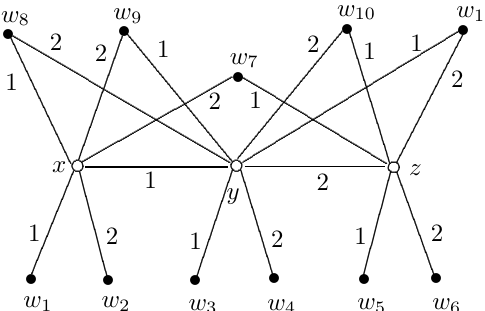
Figure 5: A proper-path 2-edge coloring of F for t =